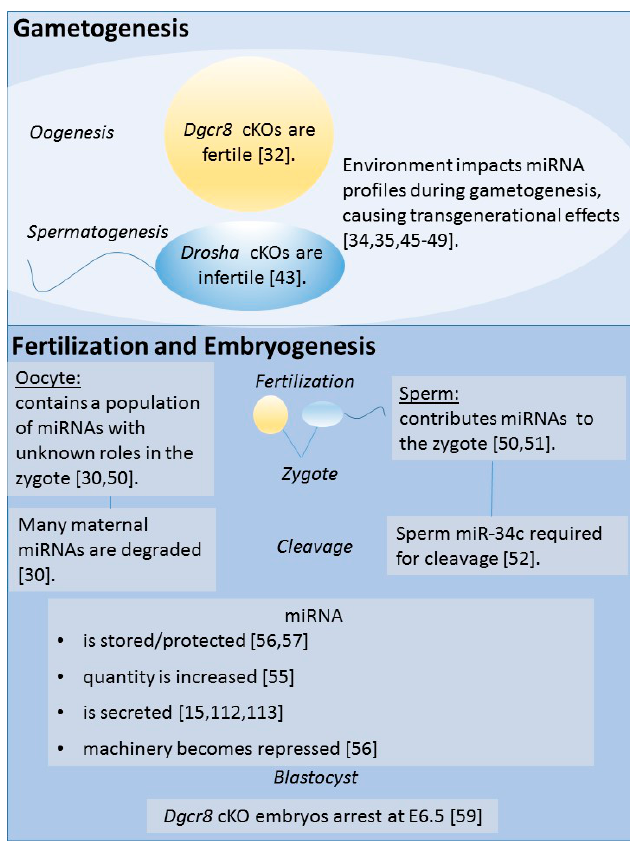
Figure 2. Links of miRNA to gametogenesis, fertilization, and embryogenesis. Knockout models have been developed to assess necessity of miRNAs in oogenesis and spermatogenesis. DGCR8 and DROSHA are both representative of protein knockouts specific to the microprocessor complex which cleaves pri-miRNA to pre-miRNA. Interestingly, females are fertile when this complex is disrupted, but males are infertile. Importantly, these models do not represent environmental impact which can occur to alter miRNA profiles. At fertilization, both the sperm and the oocyte contribute miRNA. However, the oocyte’s miRNA is rapidly degraded, so its use remains undetermined. Alternatively, it has been shown that a sperm RNA, miR-34c, is required for the first cleavage division following fertilization. In remaining divisions, control over miRNA availability is dynamic in the